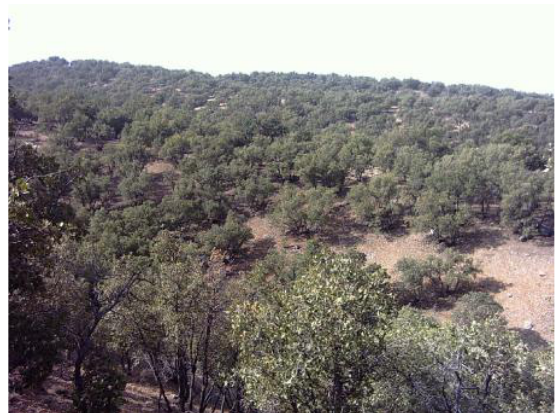
Figure 2. The study area covered with Persian oak trees.